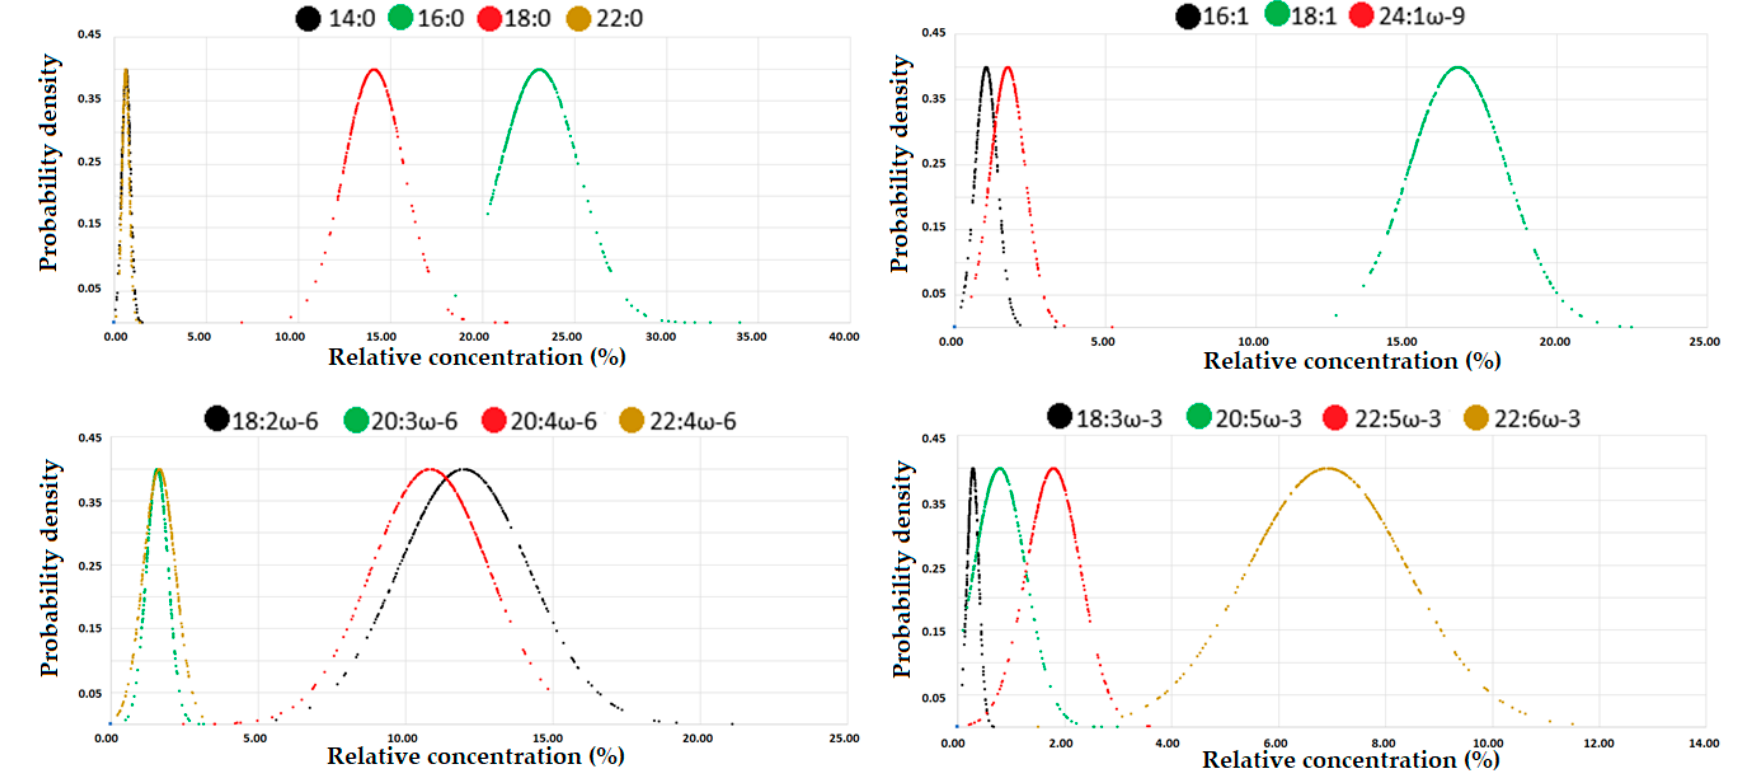
Figure 3. Normal distribution of the different groups of fatty acids (unsaturated, monounsaturated, and polyunsaturated). The graphs can be generated automatically (for % or mg/g) by copy-pasting the experimental results in Appendix C into the provided Excel-based platform.